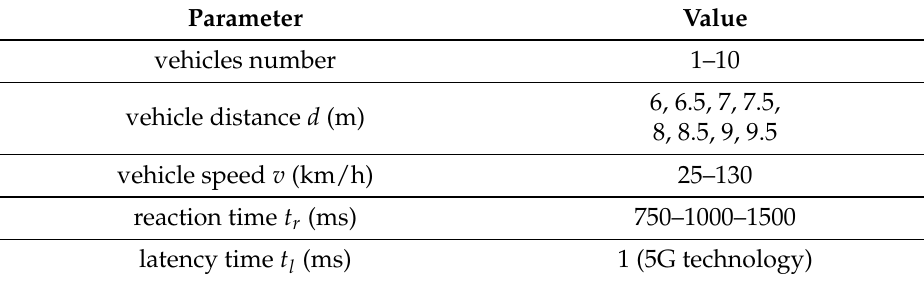
Table 6. Simulation